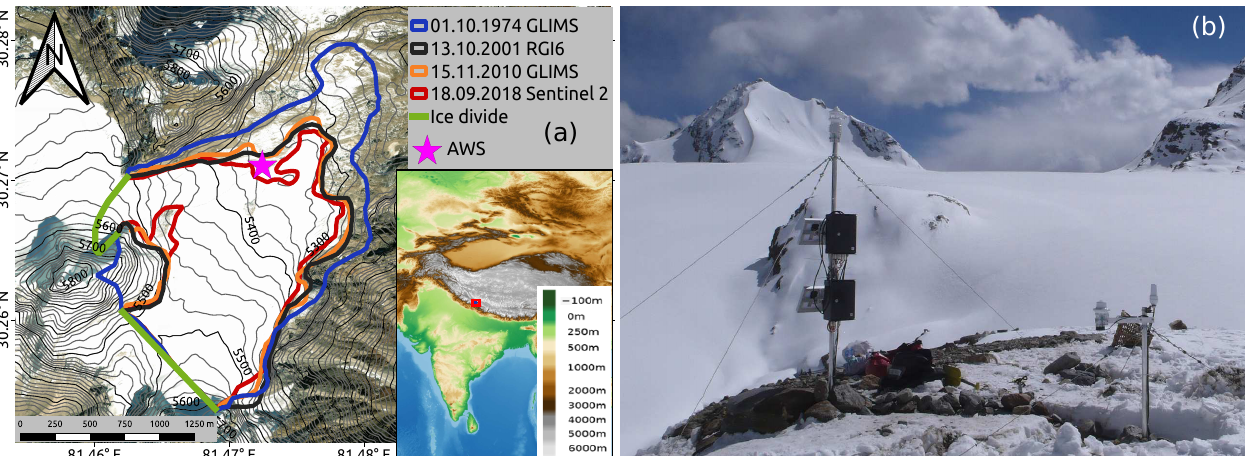
Figure 1. The Halji glacier with multi-temporal glacier outlines and satellite image map in the background [55] ( a ) and photo of the automatic weather station (AWS) of the Chair of Climatology (Technische Universität Berlin) installed in 2018 with a part of the glacier in the background ( b , photo by Benjamin Schröter). Colors within the inset map represent elevation